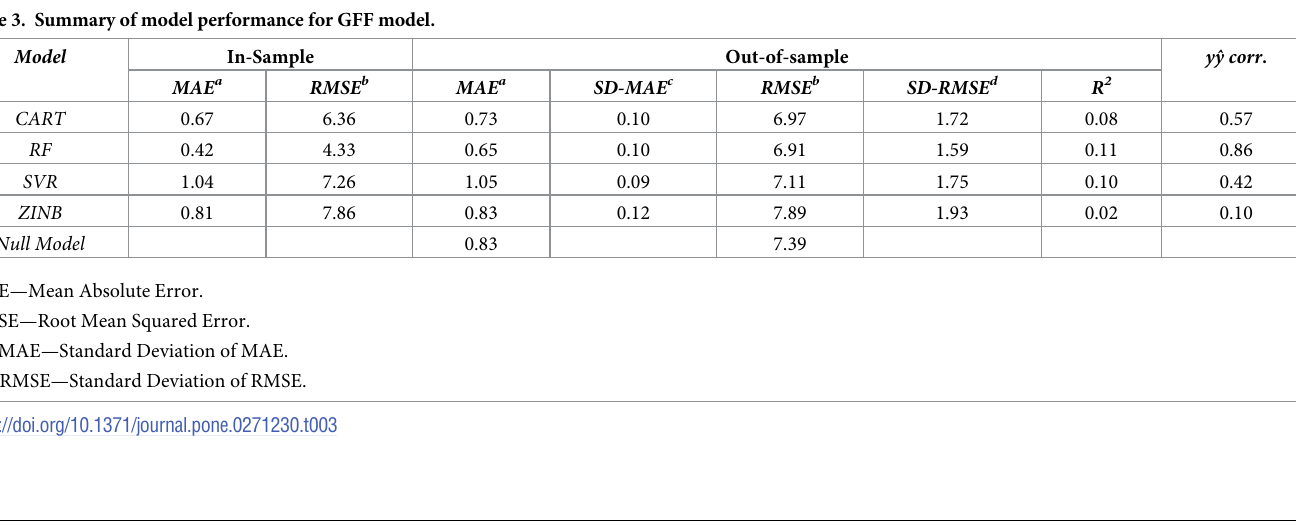
improvement over the nationwide model ( R 2 of 0.15 for the FPR model and R 2 of 0.11 for the